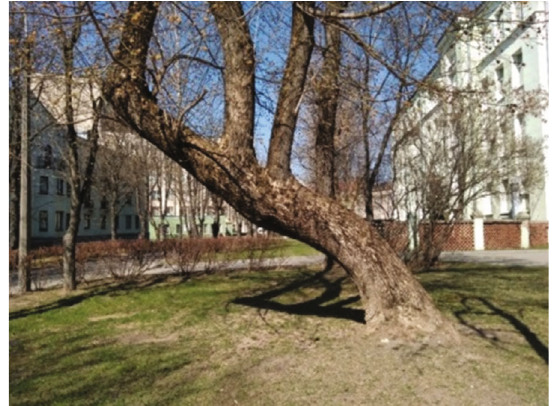
Figure 17: Obliquely growing campus tree in the need for assessment and FEA